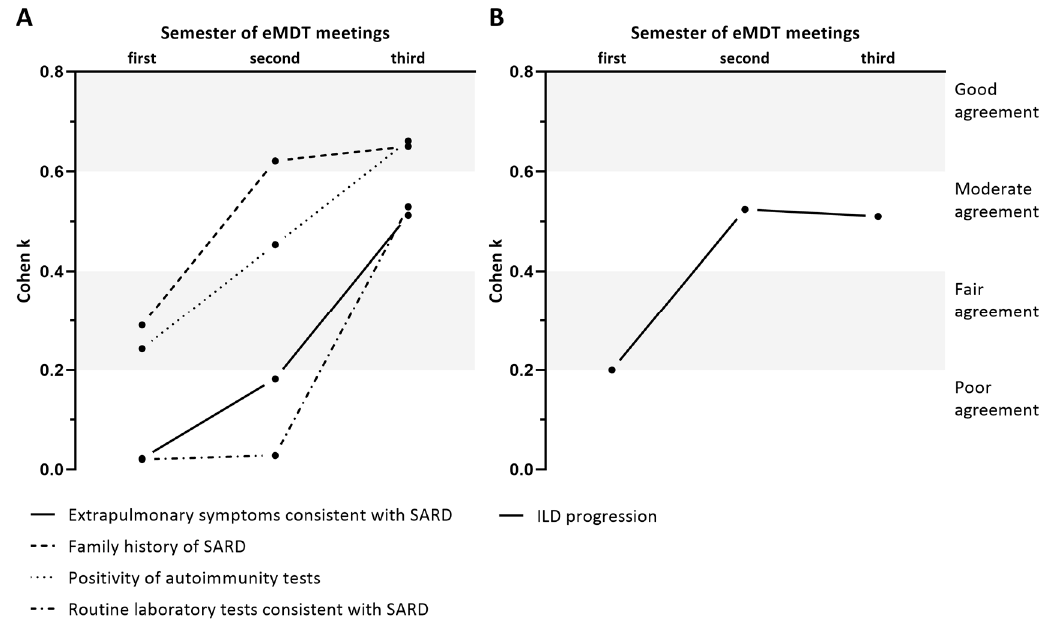
Figure 3. Level of agreement over three consecutive six-month periods between pulmonologist and rheumatologist in the identification of red flags of SARD ( A ) and between rheumatologist and eMDT in the definition of ILD progression ( B ). eMDT: multidisciplinary team extended to rheumatologists; SARD: systemic autoimmune rheumatic disease; ILD: interstitial lung disease.